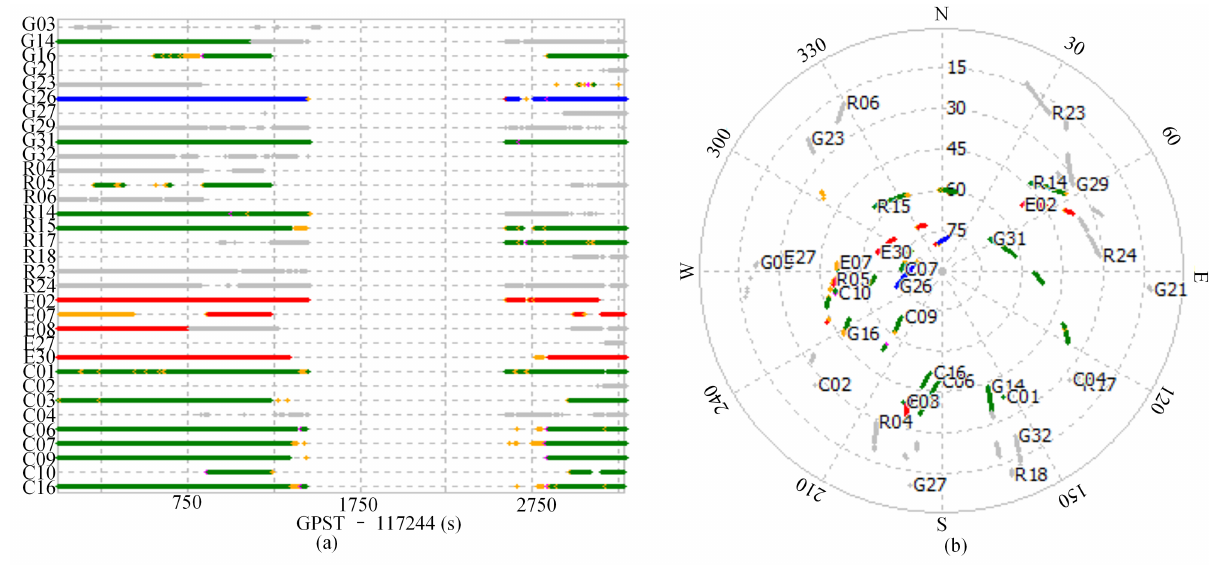
Figure 6. Satellite availability in a dense urban environment with a 35 ◦ cut-off elevation angle. ( a ) Satellite availability. ( b ) Starry sky map of satellites.